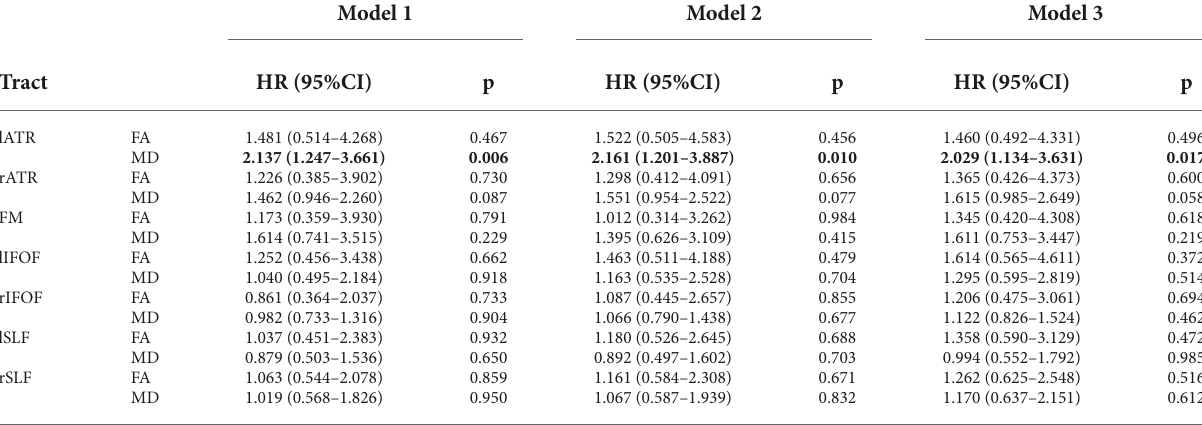
TABLE 3A Cox proportional hazard models of the DTI values for the incidence of frailty according to the mCHS ( n = 137).